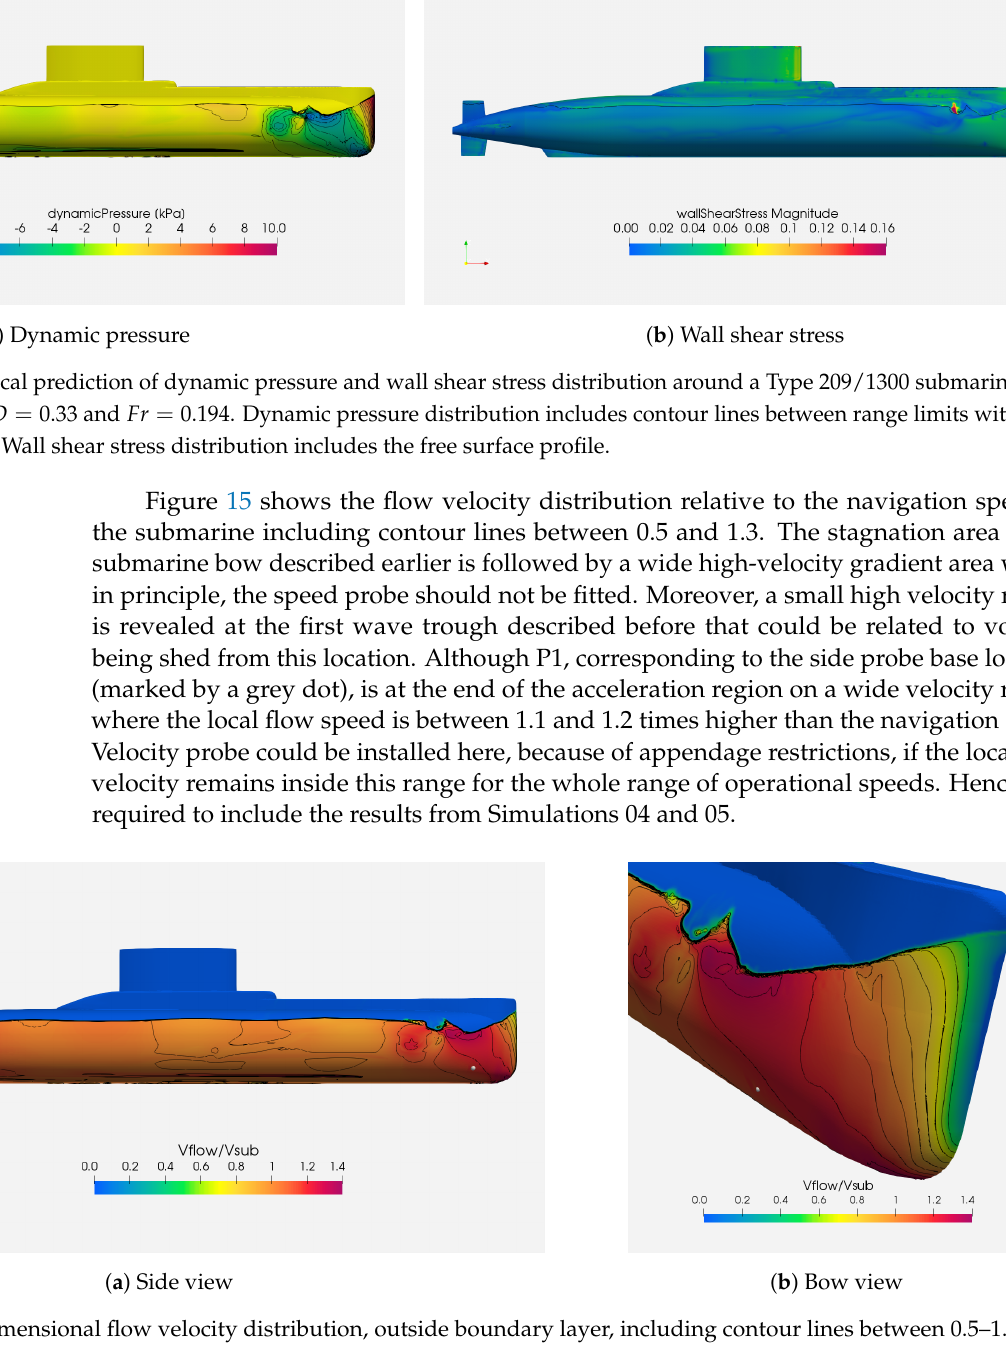
Figure 15. Non-dimensional flow velocity distribution, outside boundary layer, including contour lines between 0.5–1.3 with steps of 0.1, around a Type 209/1300 submarine at condition 1 H / D = 0.33 and Fr =